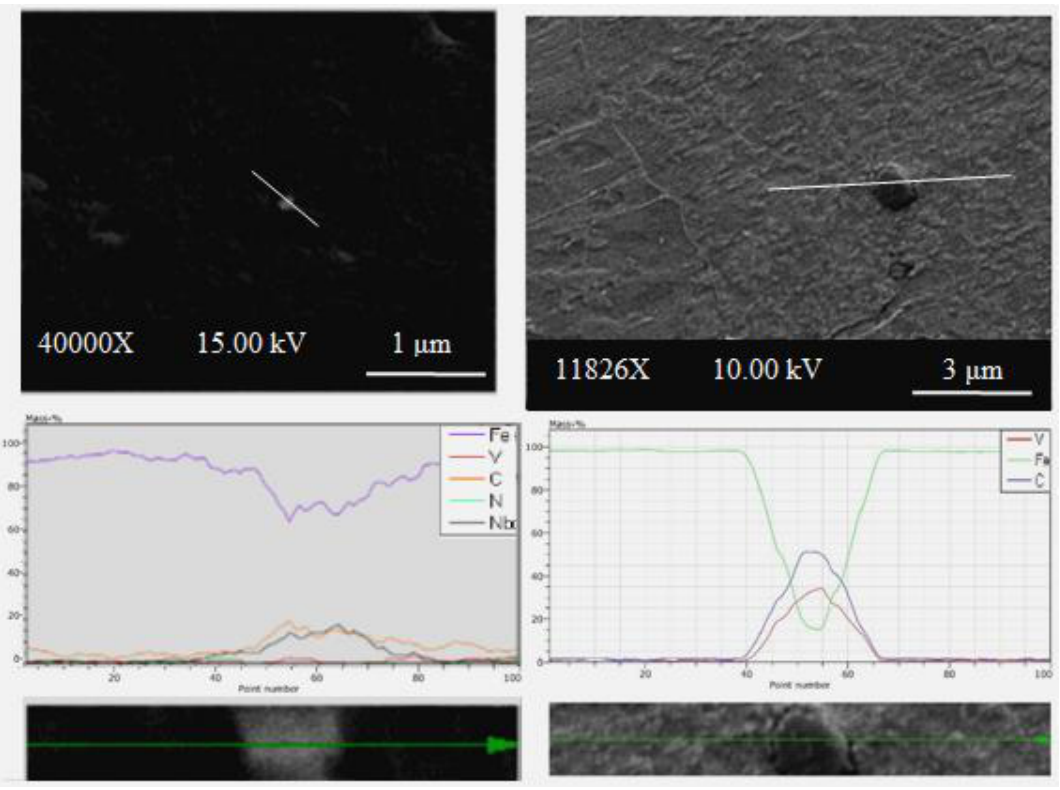
Figure 9. SEM micrograph for Alloy 3 sintered at 1350 °C and the EDS lines scan of the indicated particle.